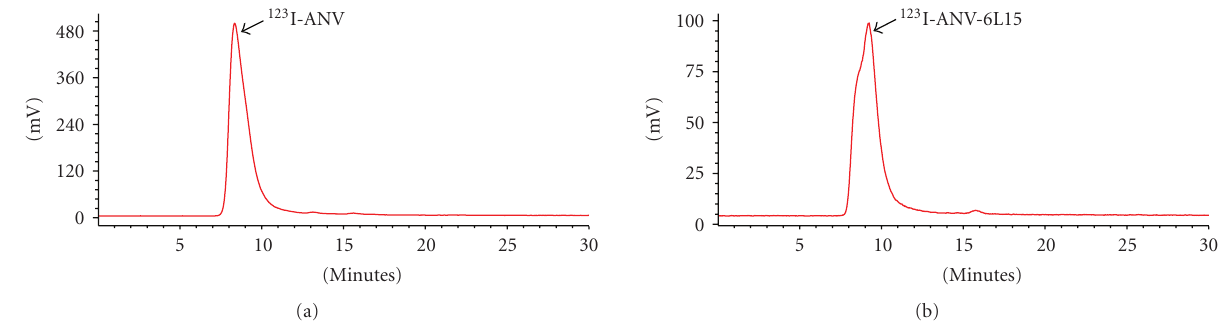
Figure 1: Representative HPLC radiochromatograms of (a) 123 I-ANV and (b) 123 I-ANV-6L15. HPLC analysis was performed on a Waters Ultrahydrogel 250 column, (7 . 8 × 300 mm, 6 μ m) guarded with a Waters Ultrahydrogel guard column (6.0mm × 40mm, 6 μ m), with mobile phase of isocratic 0.01 M KH 2 PO 4 solution (pH 7.4) at a flow rate of 0.8 mL/min.